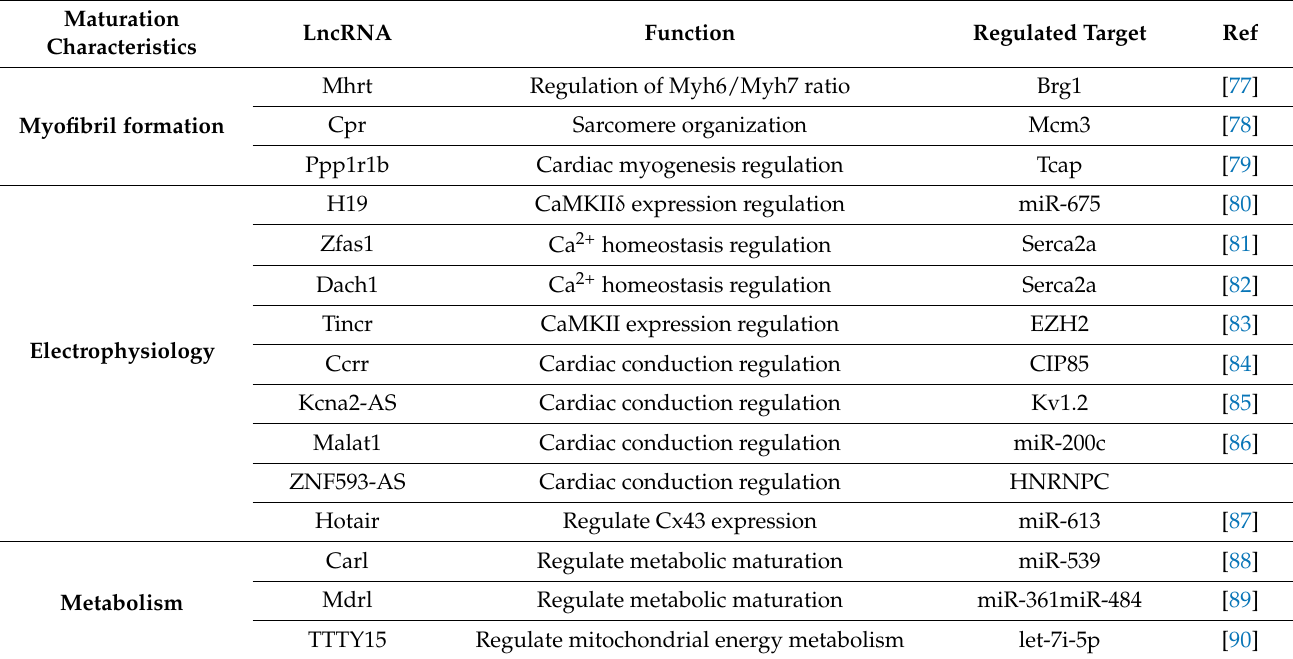
Figure 2. Classification of LncRNA. ( A ) LncRNAs may be divided based on their position and orientation relative to protein-coding genes (genomic context) or by distinct chromatin marks around their transcription start-sites (chromatin context). ( B ) More details are described within the text. Table 1. LncRNAs with potential roles in the cardiomyocyte maturation